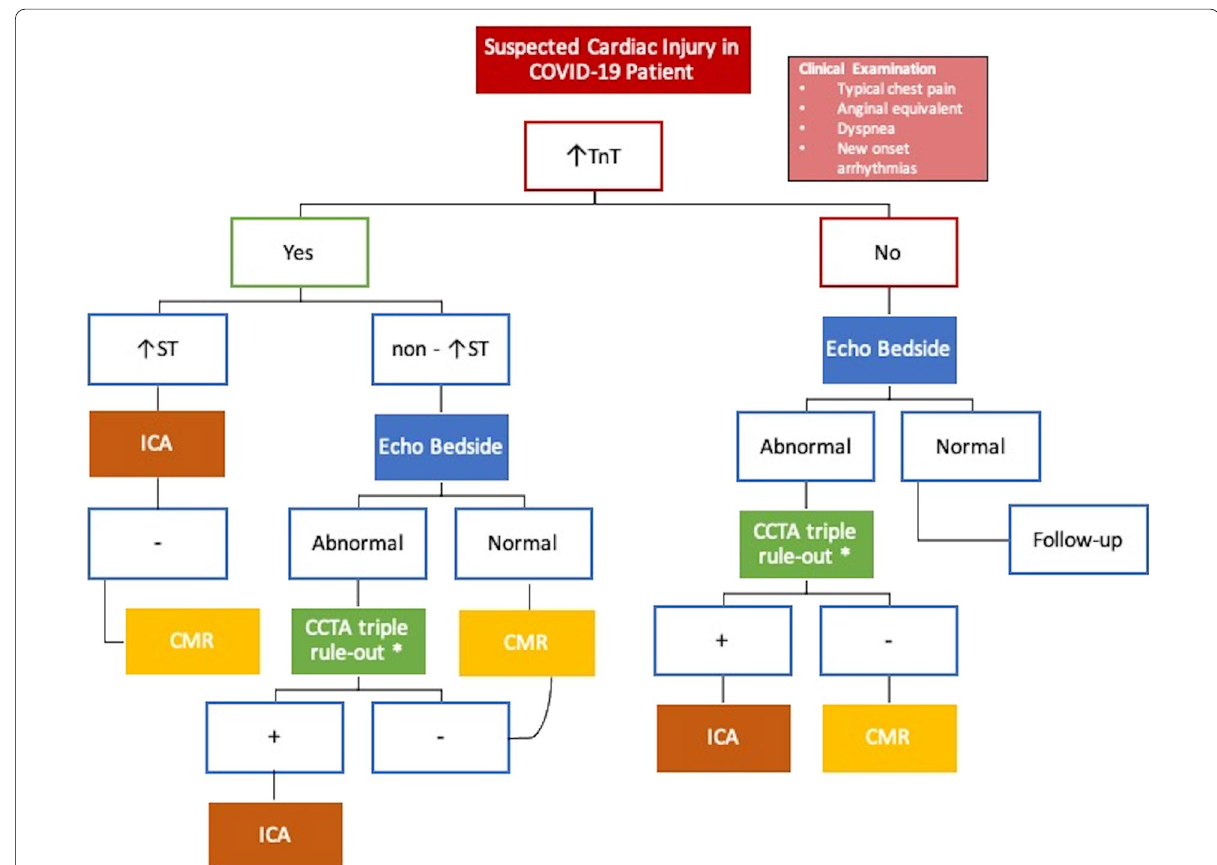
Fig. 8 Suggested flowchart for imaging management of suspected cardiac injury in COVID-19 patients. (*) CCTA can be considered to triple rule-out CAD, interstitial pneumonia and pulmonary embolism in selected patients. TnT T-troponin; Echo echocardiography; ICA invasive coronary angiography; CCTA cardiac computed tomography angiography; CMR cardiac magnetic